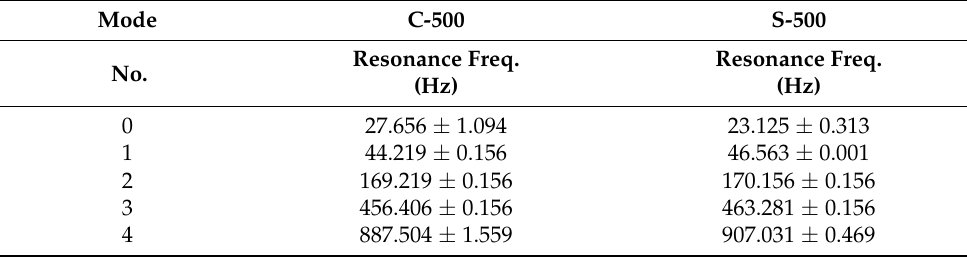
Figure 12. Modal identification for the 500 mm-length—FRF plot for ( a ) setup 1 and ( b ) setup 4. Table 9. Identified natural frequencies for the 500